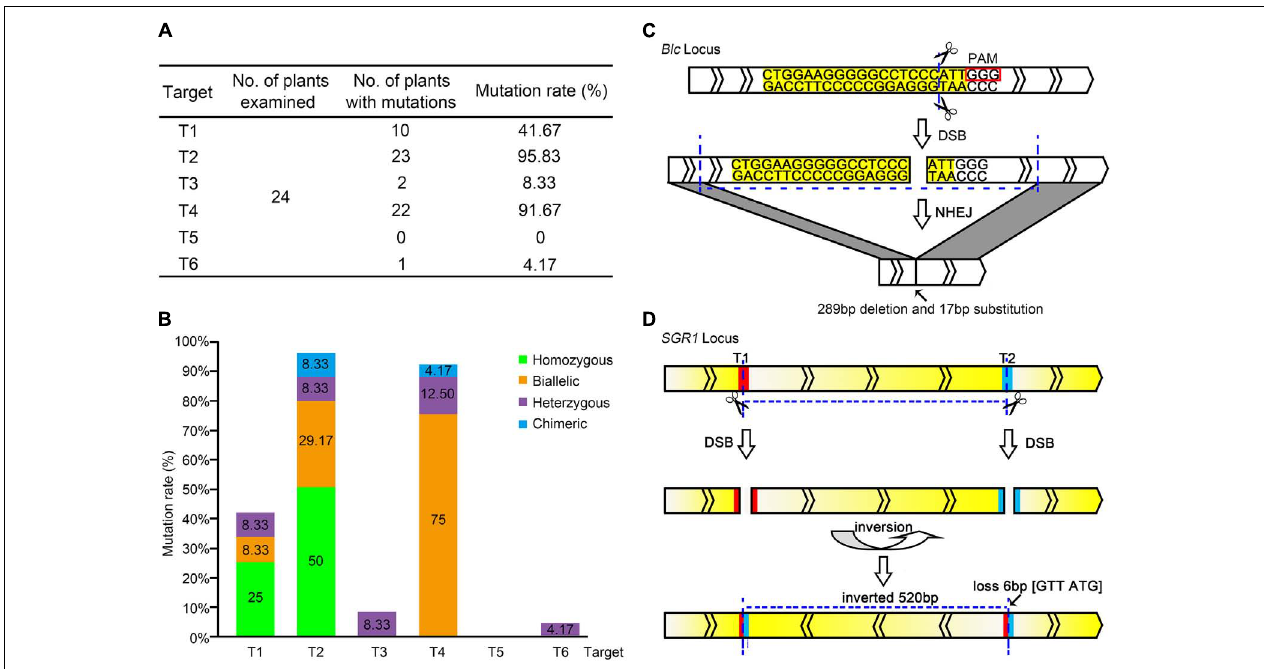
FIGURE 2 | Editing of each target site in the pYLCRISPR/Cas9-lycopene expression cassette. (A) Total editing efficiency of the six targets in the pYLCRISPR/Cas9-lycopene expression cassette. The mutation rate is the ratio of the number of mutations detected to that of the total number of plants in which mutations are detected. (B) Specific types of each target among the six target sites in the pYLCRISPR/Cas9-lycopene expression cassette. Green, orange, purple, and blue represent homozygous, biallelic, heterozygous, and chimeric mutations, respectively. (C) Large fragment deletion on Blc . Target sequence is labeled with yellow. Small rectangle frames indicate the protospacer adjacent motifs. The transcriptional direction of the Blc is shown. (D) Special DNA inversion on SGR1 . The red and blue parts represent the targets T1 and T2, respectively. Gradient change of color between yellow and white indicates the transcriptional direction of SGR1